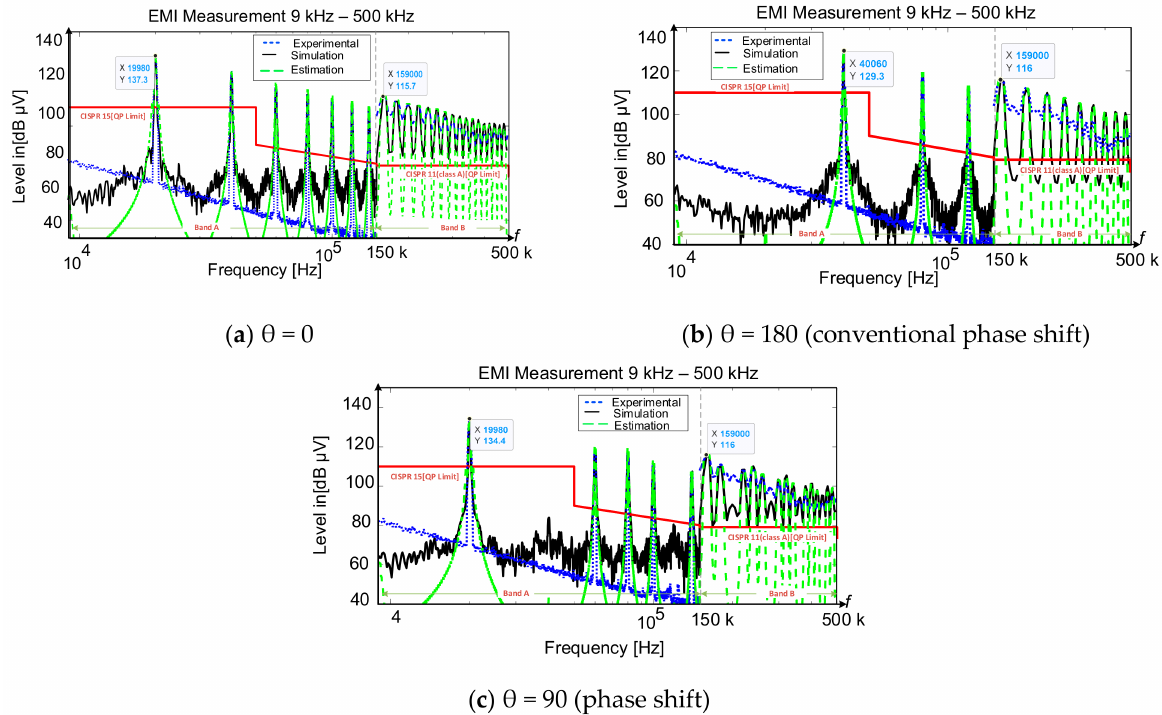
Figure 15. EMI results measurement for 2-unit interleaved boost PFC converter, including estimation-based proposed model, simulations, and experiments for different phase shift including ( a ) 0 ◦ , ( b ) 180 ◦ , and ( c ) 90 ◦ . Test system specification is on the basis of results given in Table